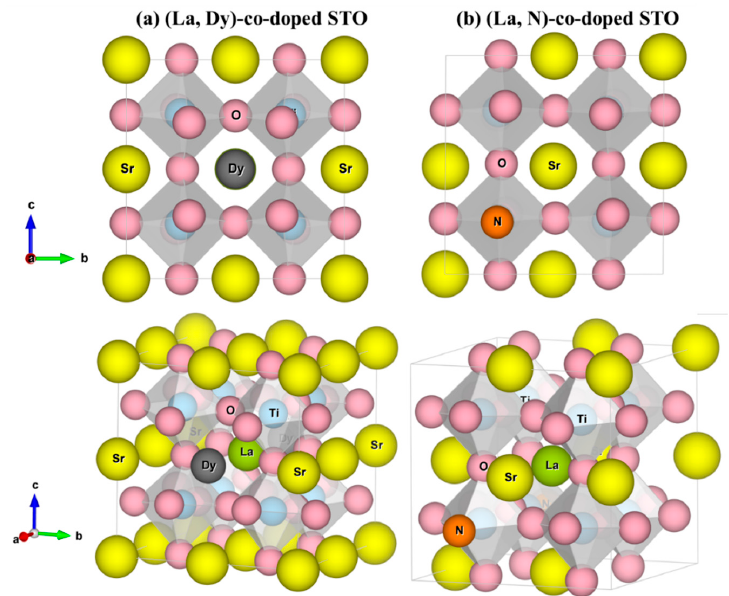
Figure 2. Optimized structures of ( a ) (La, Dy) co-doped SrTiO 3 and, ( b ) (La, N) co-doped SrTiO 3 . Yellow, blue, pink, green, gray and orange spheres represent Sr, Ti, O, La, Dy and N, respectively. The total density of states (TDOS) of the undoped SrTiO 3 is illustrated in Figure 3a. Red dashed lines at x = 0 represent Fermi levels. The Fermi level ( E f ) is 7.27 eV, and this is the conduction band minimum. Therefore, undoped SrTiO 3 exhibits n-type behavior, in agreement with experimental measurements and other literature reports [34,35]. After La doping, the highest state that the carriers occupy is the ground state or Fermi level ( E f ), located at the bottom of the conduction band, at 8.00 eV, as seen in Figure 3c,d. E f shifts to higher energy compared to undoped SrTiO 3 . This is caused by an increase of uration of Sr is Kr 5s 2 , while that of La is Kr 4d 10 5s 2 5p 6 5d 1 6s 2 . In other words, the oxida- E f shifts to 7.79 eV with electron doping for Dy doping on the Sr site because Dy and La have the same oxidation number as previously mentioned. For N doping, the Fermi level shifts from the conduction band to the valence band and new states are found around the valence band maximum in the N mono-doped structures. The Fermi level of N-doped SrTiO 3 is 4.48 eV. The Fermi energy shifts to a lower level because oxygen substituted by nitrogen is a p-type doping or hole doping and the number of electrons is reduced. The electron configurations of O and N are He 2s 2 2p 4 and He 2s 2 2p 3 , respectively. Notably, from the PDOS graphs, O and Ti atoms contribute the valence band maximum and con- duction band minimum for all mono-doping systems.